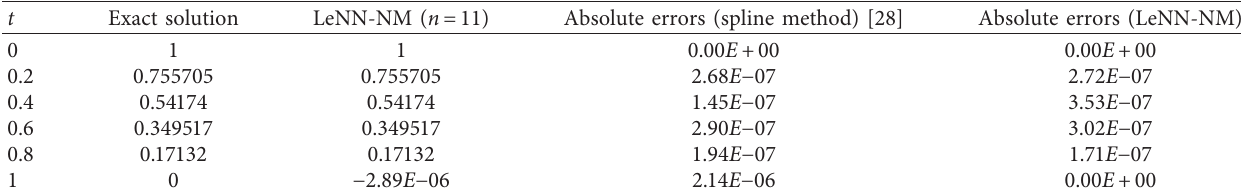
Table 3: Result comparison of LeNN-NM algorithm with the exact solution and spline Method [28] along with absolute errors for Problem